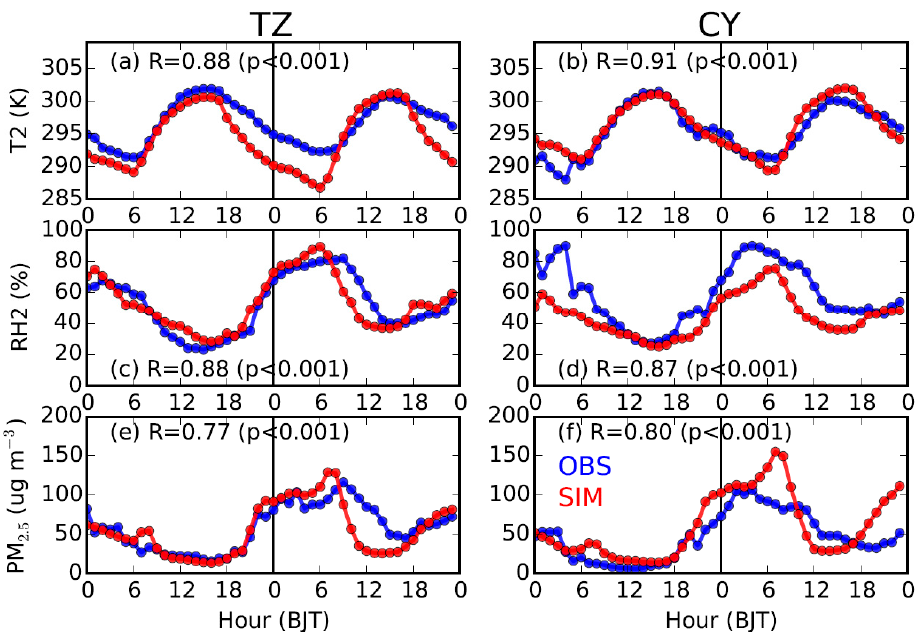
Figure 5. Time series of observed (in blue) and simulated (in red) (top to bottom) 2-m temperature, 2-m relative humidity (RH2), and near-surface PM 2.5 concentration at ( left ) Tongzhou (TZ) and ( right ) Chaoyang (CY) stations from 19 to 20 September 2015. The correlation coefficients (R) between the simulations and observations are also shown for each panel.